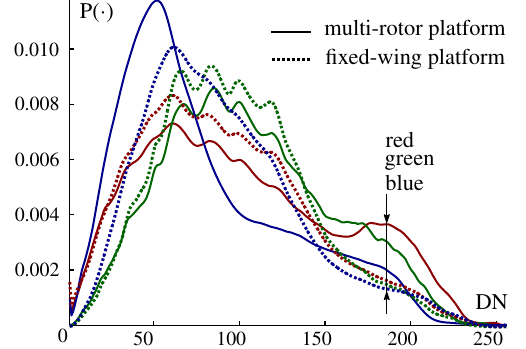
Figure 5: Normalized histogram of digital numbers (DN) for dif- ferent color channels. The population came from 300 images for the fixed-wing configuration and 148 for the multi-rotor platform.